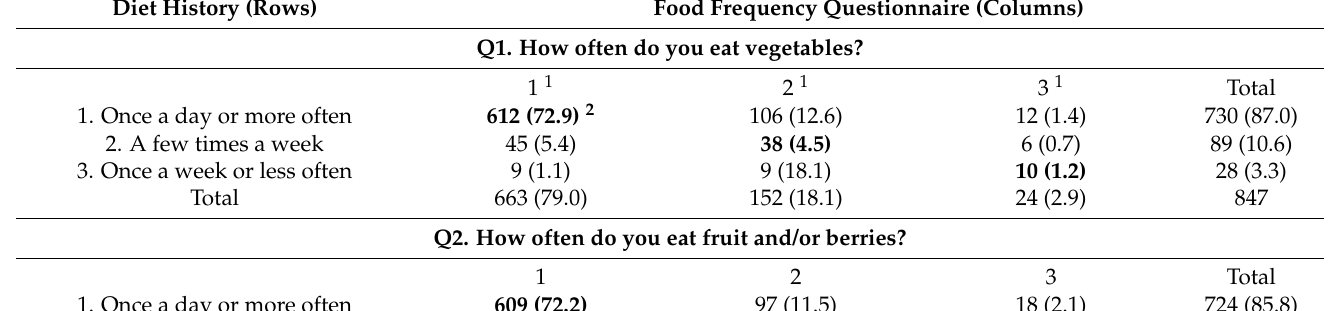
Table 2. Comparison of distributions on each food item for FFQ (columns) and DH (rows). Diet History